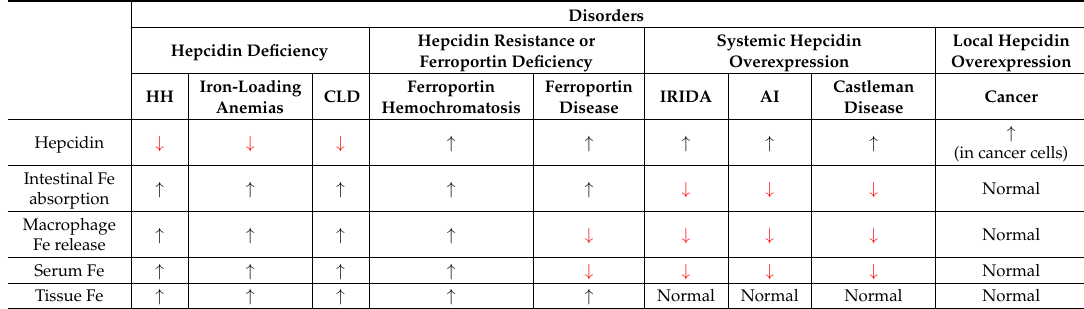
Table 1. Iron-related disorders of hepcidin dysregulation. Deficiency or excess of hepcidin has a different physiological effect on intestinal iron absorption, iron release by macrophages, serum iron, and tissue iron. HH, Hereditary Hemochromatosis; CLD, Chronic Liver Disease; IRIDA, Iron-Refractory Iron Deficiency Anemia; AI, Anemia of Inflammation. Disorders Hepcidin Resistance or Systemic Hepcidin Local Hepcidin Hepcidin Deficiency Ferroportin Deficiency Overexpression Overexpression Iron-Loading Ferroportin Ferroportin Castleman HH CLD IRIDA AI Cancer Anemias Hemochromatosis Disease Disease